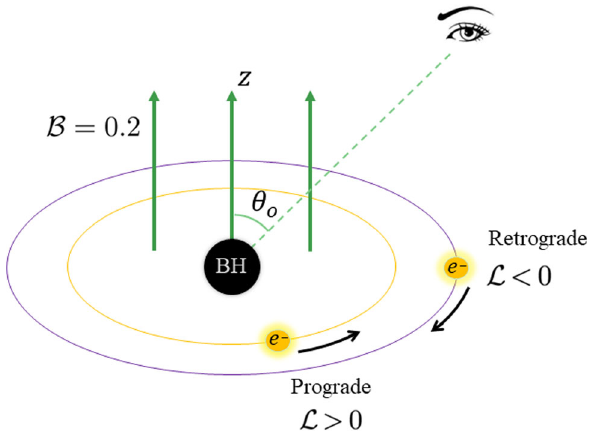
Fig. 2 Adiagramofretrograde( L < 0)andprograde( L > 0)orbitsof electrons. We set the direction of the magnetic field (cid:10) B along the positive axis of z . θ o is the inclination angle of the